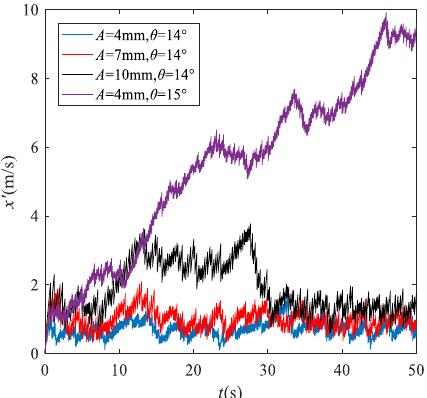
Figure 10. Particle speed in 50 s at A = 4, 7, 10 mm, θ = 14, 15°, a = 90°, and f = 16 Hz.